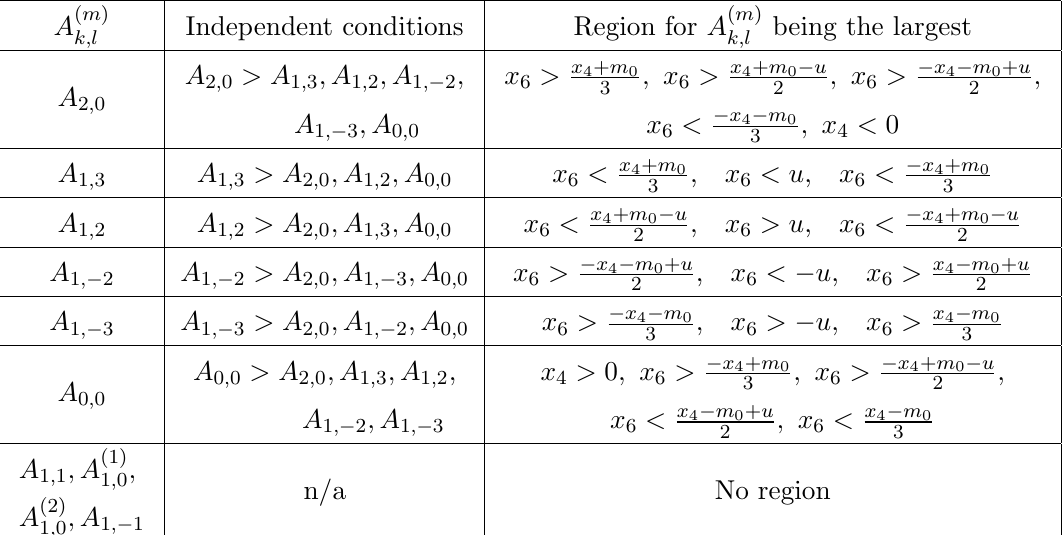
becomes larger than any other A ( m k;l